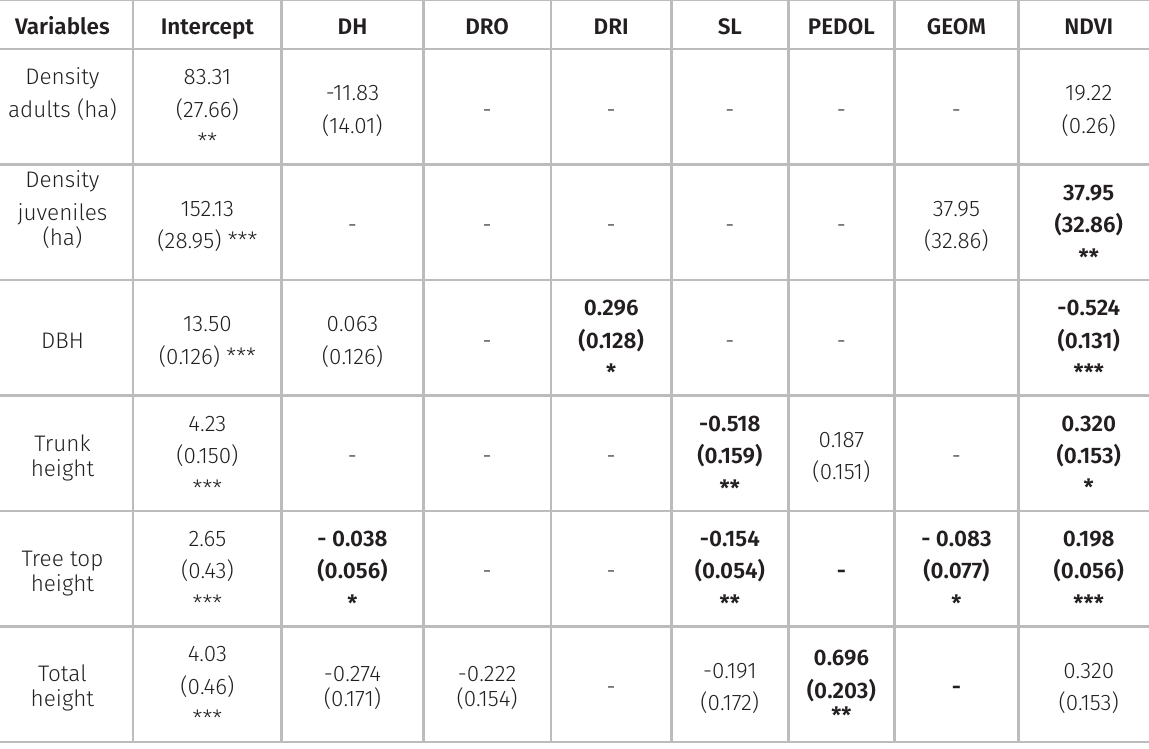
Table I. Mean coefficients (standard errors) of the model predicting the characteristics of tucumã-do-pará populations according to abiotic variables. Legend: DH - distance from houses, DRO - distance from roads, DRI - distance from rivers, SL - slope, PEDOL - pedology, GEOM – geomorphology, and